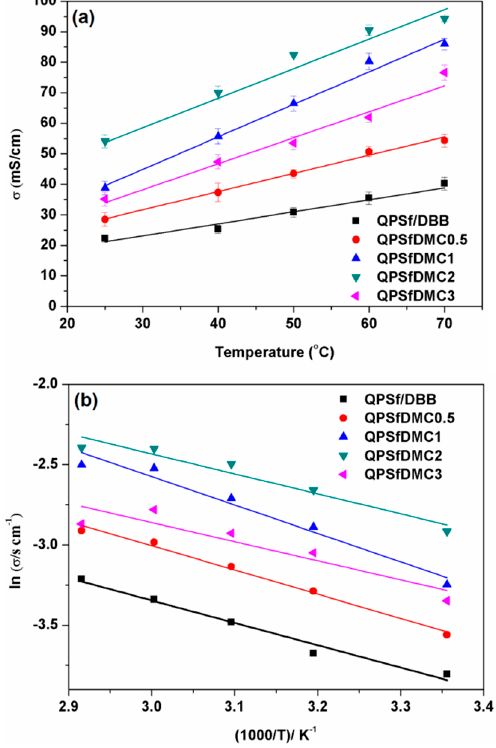
Figure 6. ( a ) Ionic conductivity versus temperature and ( b ) the Arrhenius plot for the different membranes.